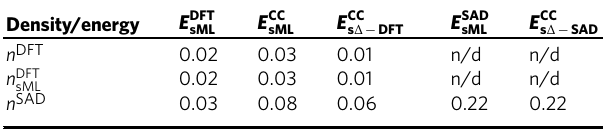
Table 3 MAEs (kcal mol − 1 ) for the MD17 benzene test set for the different density inputs and energy